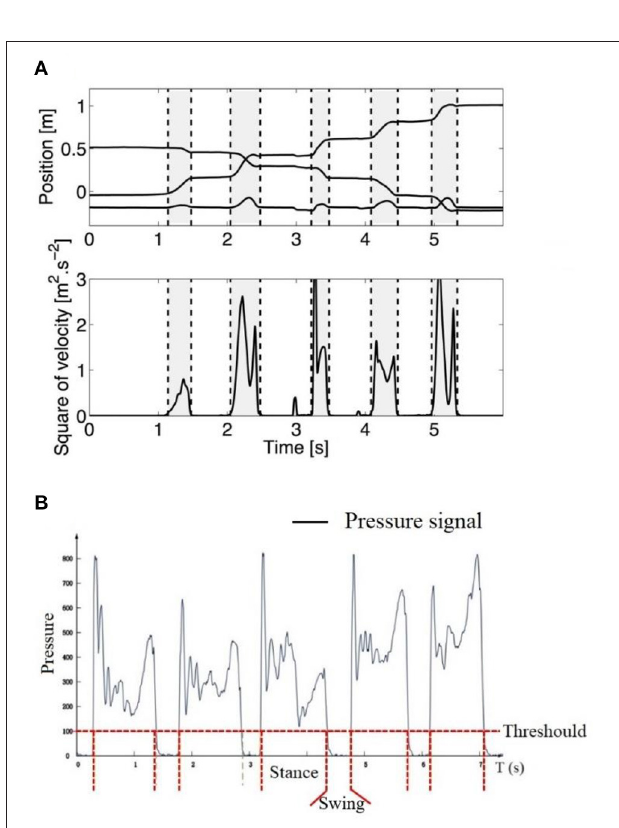
FIGURE 6 | (A) Example of stance and swing determined by the trajectory of the wrist (upper graph, the lower line is the vertical direction, whereas the middle and upper one are, respectively, the horizontal and lateral directions). Vertical dashed lines separate swing (gray) and stance (white) phases (26). (B) Example of stance and swing determined by pressure threshold. Greater than the pressure threshold for the stance phase and less than the pressure threshold for the swing phase